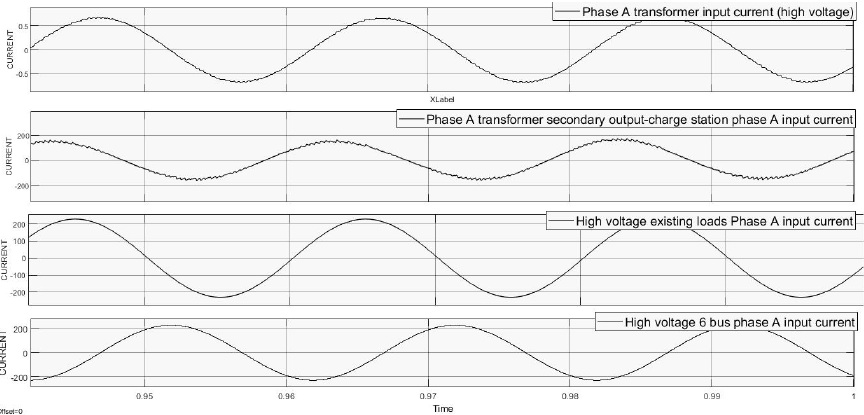
Figure 5. The 6- bus system EV charging station current signals.